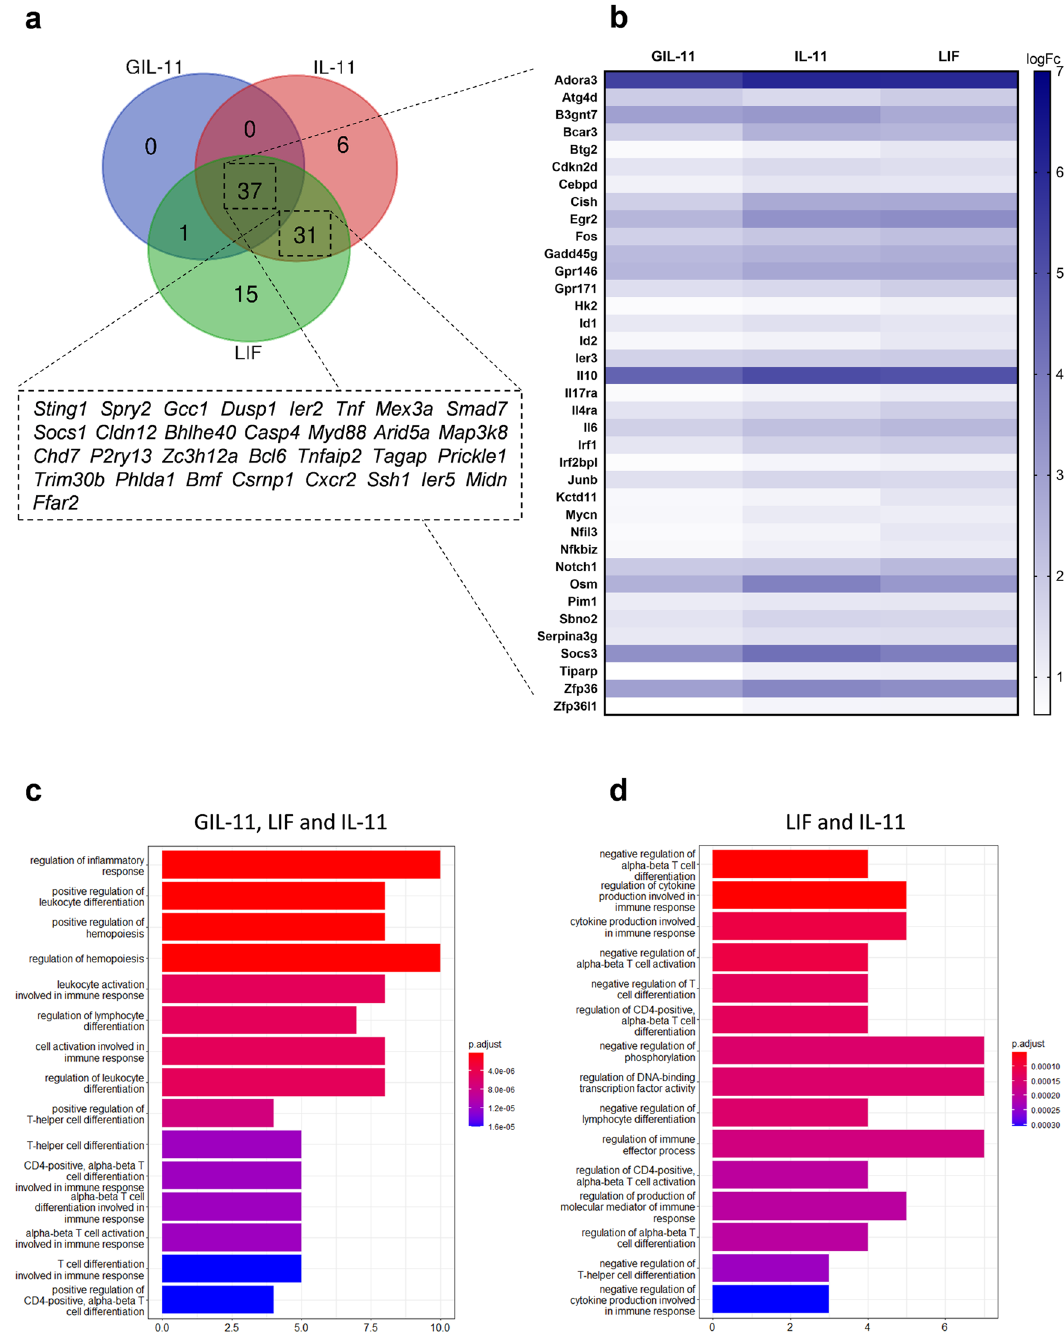
Fig. 3 Transcriptome pro fi ling of Ba/F3-gp130:IL-11R:LIFR cells demonstrate attenuated gene activation by GIL-11. a Venn Diagram shows overlap of genes that are activated by natural or synthetic cytokines. Filter: p < 0.05 including false discovery rate correction; |FC| ≥ 1.5. b Heat map shows genes that are signi fi cant increased by GIL-11 vs untreated, IL-11 vs untreated and LIF vs untreated. Scale bar shows log fold change. Filter: p < 0.05 including false discovery rate correction; |FC| ≥ 1.5 Gene ontology analysis of common gene pathways that are activated by GIL-11, LIF and IL-11 ( c ) and by the natural cytokines only ( d ). Filter: p < 0.05 including false discovery rate correction; |FC| ≥ 1.5. X-axis: number of genes involved in common gene pathway. Gene expression accession code: